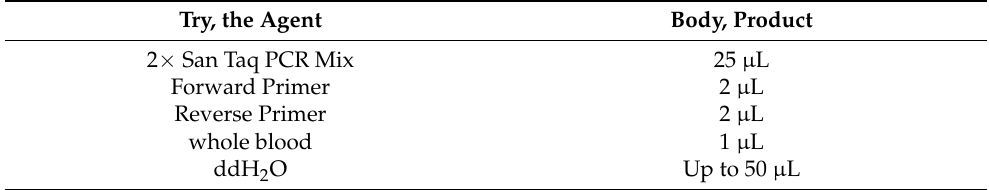
Table 1. Micro-trace whole blood PCR system. Try, the Agent Body,